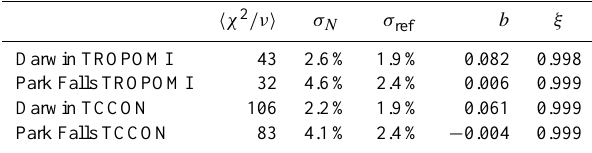
Table 4. Fit diagnostics of the H 2 O column retrievals at the 4190– 4340cm − 1 range, for the original (TCCON) and for the TROPOMI